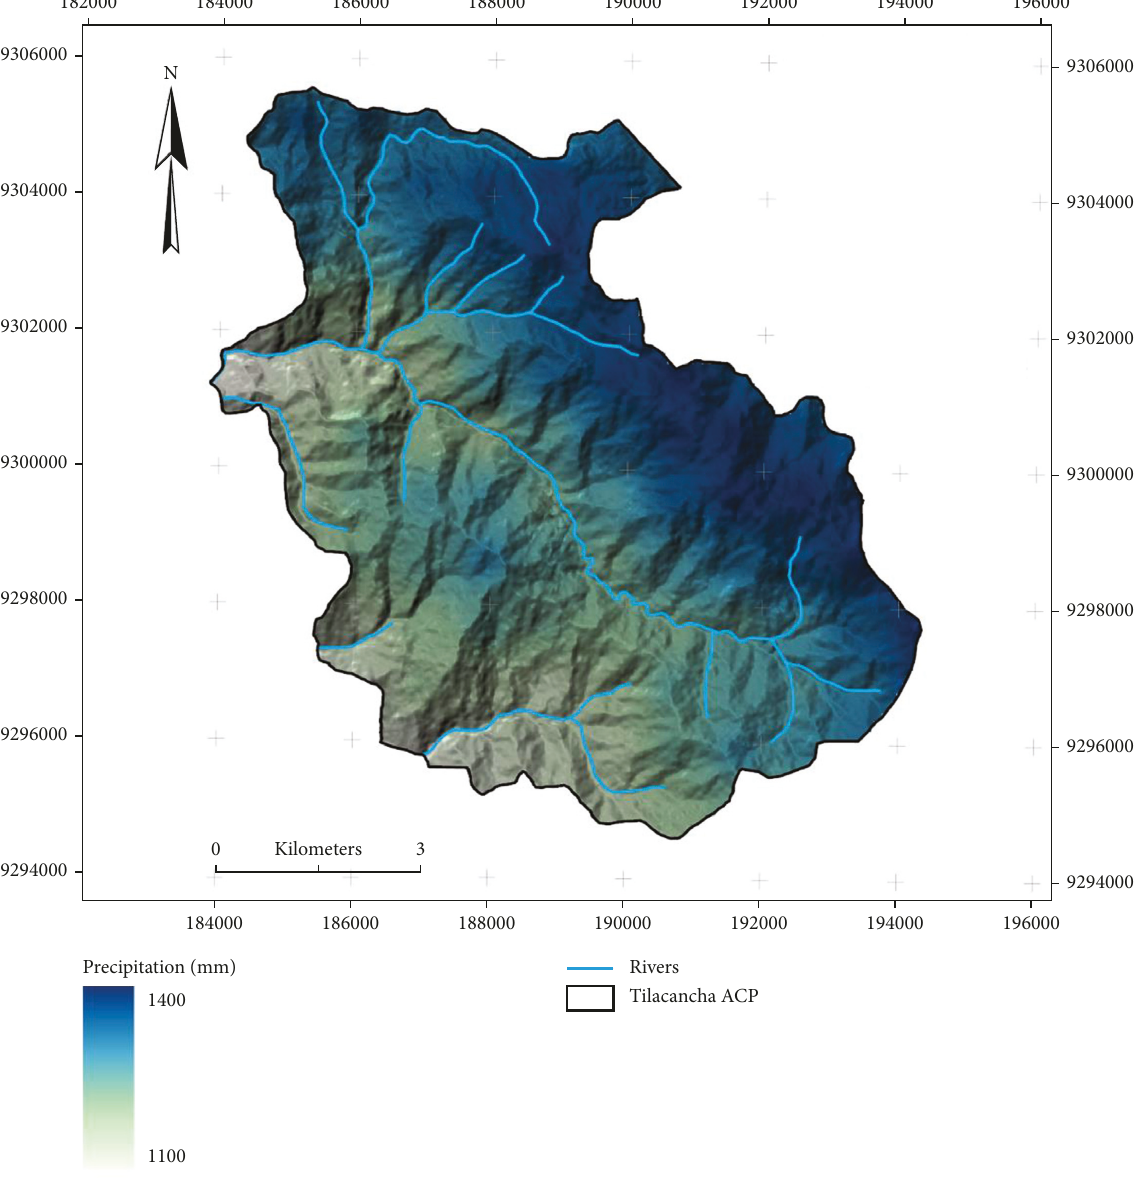
Figure 6: Estimation of water erosion using USLE in the Tilacancha ACP: (a) estimated water erosion with water erosion with annual pp, and (c) estimated water erosion with an increase of +15% of annual pp.